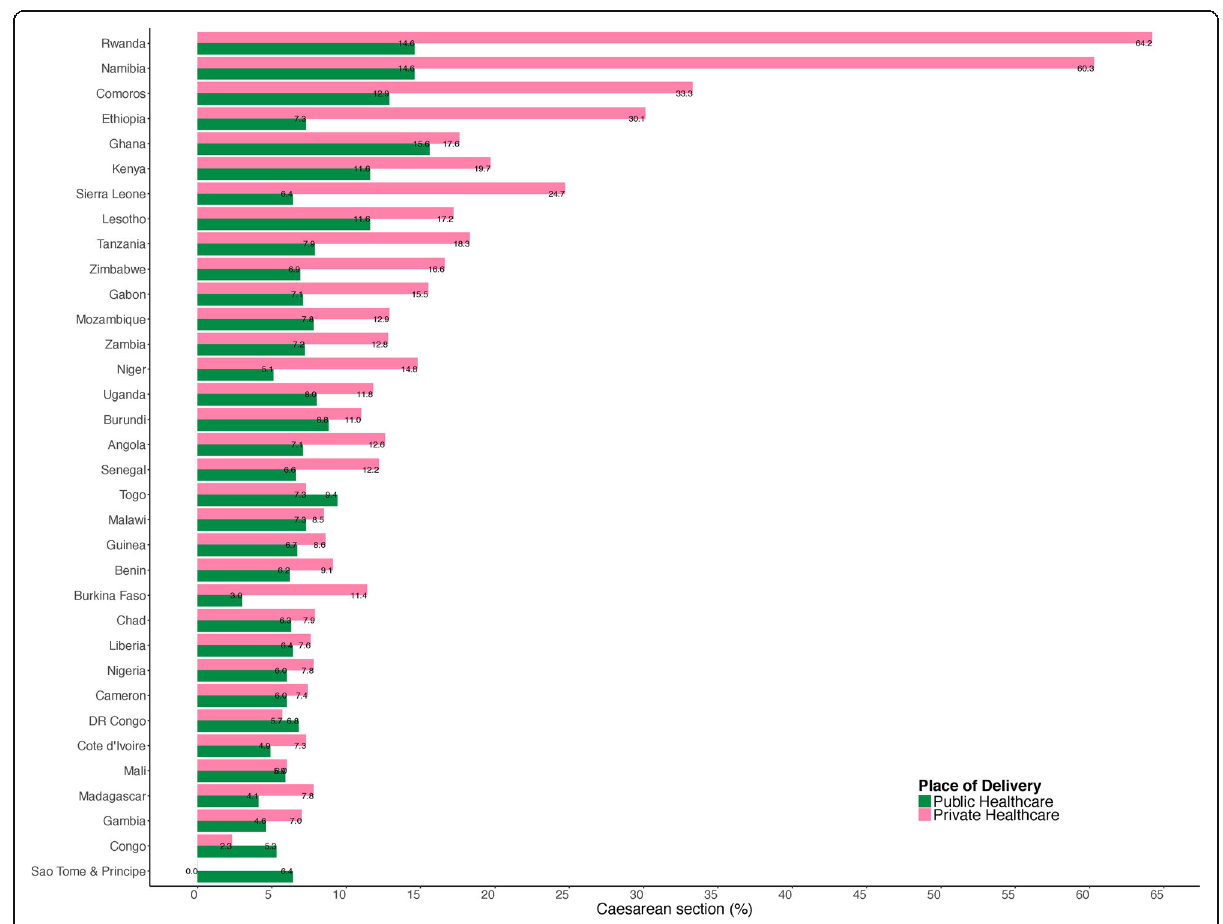
Fig. 1 Caesarean section among women in sub-Saharan